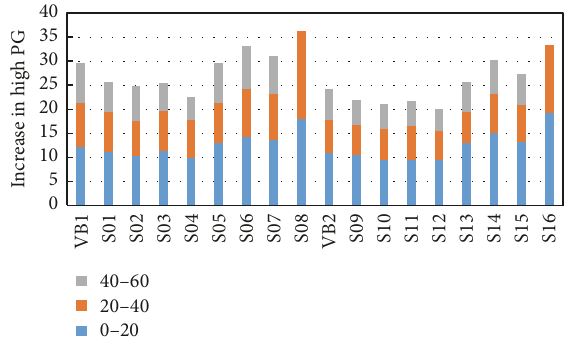
Figure 5: Variations of critical PAV time with rejuvenator content.